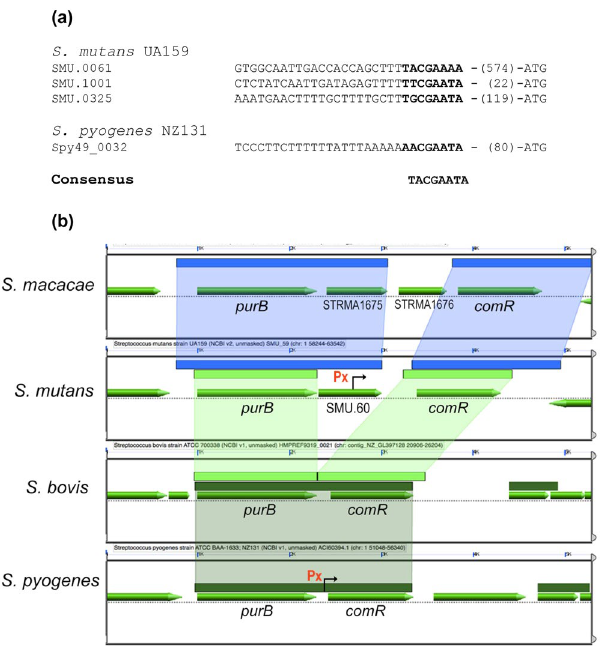
Figure 7. Alignment of DNA sequences upstream of comR in S. mutans UA159, S. pyogenes NZ131, S. bovis ATCC700338, and S. macacae NCTC11558. ( a ) In bold are the SigX-boxes in the Px promoters for comR in S. mutans and S. pyogenes . No apparent SigX-box was identified in S. macacae or S. bovis . The SigX-box regions of the most induced locus, dprA (SMU.1001), and of the least induced locus, dut/radA (SMU.0325) are also shown. ( b ) Synteny in the comR region as determined by CoGe:GEvo, using the conserved purB gene as a reference (https://genomevolution.org/coge). Mutans group; Synteny in the comR region was found only in S. macacae , as determined by CoGe:GEvo, using the conserved purB gene as a